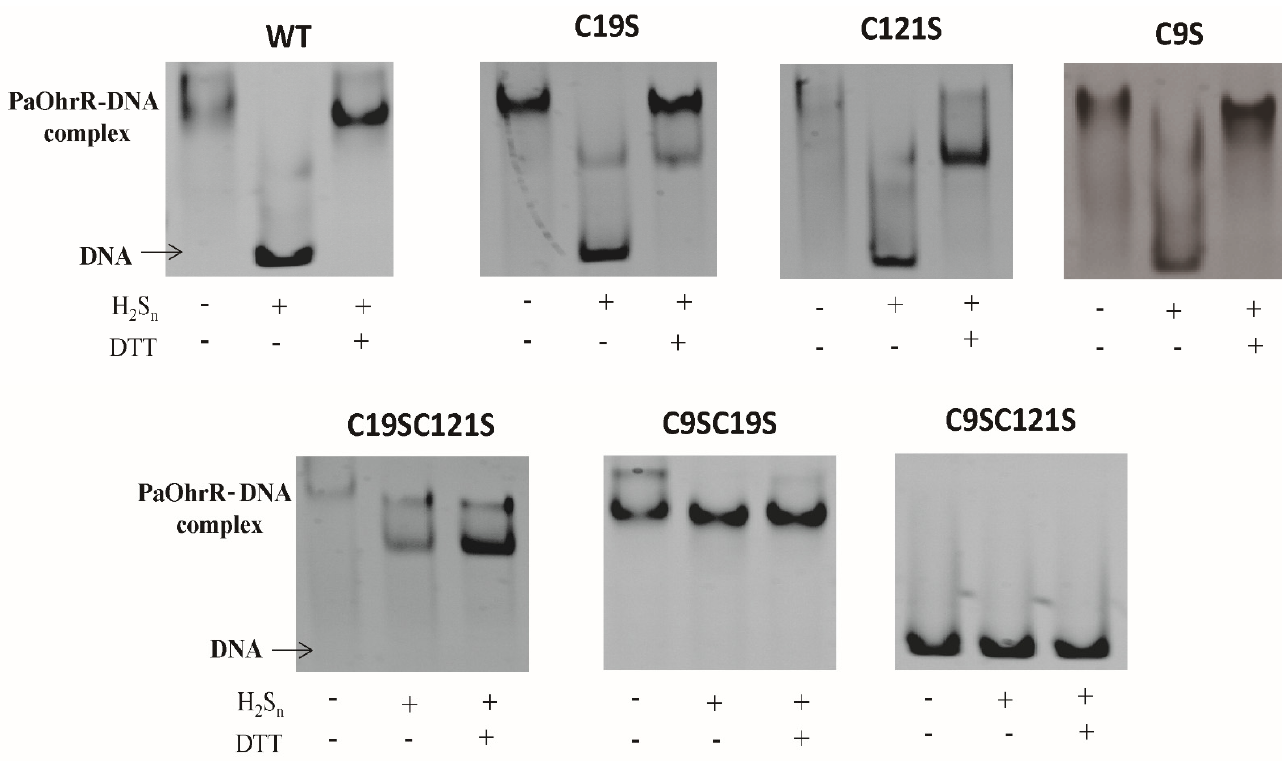
Figure 2. Three PaOhrR Cys residues were involved in sulfane sulfur sensing. The wild type (WT) PaOhrR and its mutants were treated with H 2 S n (800 μ M) for 20 min; the proteins (1.2 μ M) were then incubated with 20 nM DNA for EMSA. A total of 10 mM DTT was used to reduce H 2 S n -modified Cys residues back to free thiols.